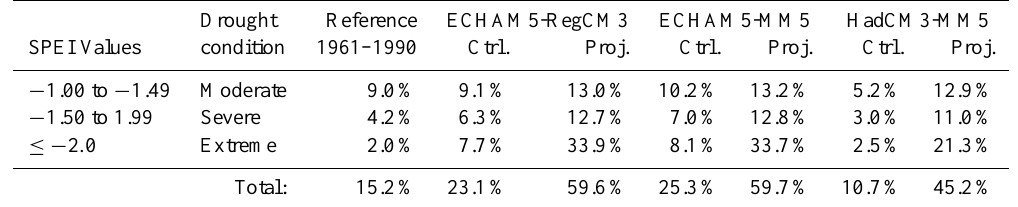
Table 1. The percentage of time with moderate, severe and extreme drought conditions as derived with the 6-month SPEI. The values are standardized according to the reference period 1961–1990 (observed data). “Ctrl.” refers to the climate model control run (1961–1990) and “Proj.” to the future projection (2031–2060).